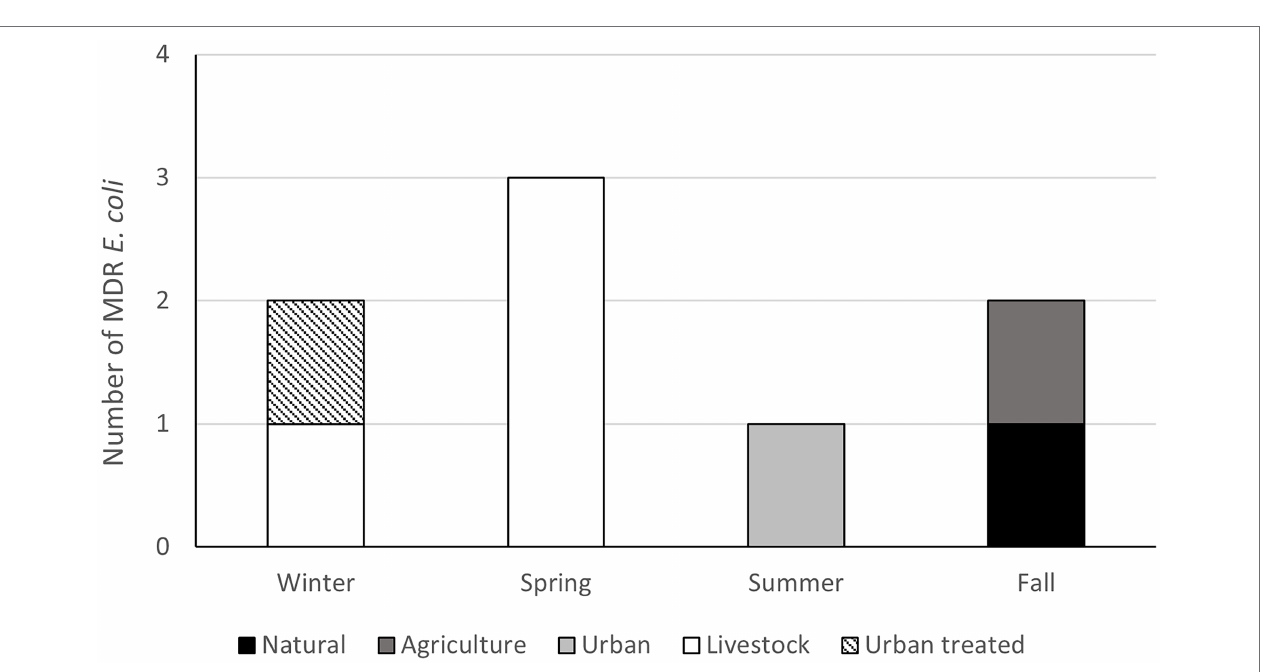
FIGURE 6 | Number multi-drug resistant (MDR) Escherichia coli by land use and season. Isolates resistant to three or more antimicrobial classes were cataloged as MDR following previously standardized criteria (Magiorakos et al.,